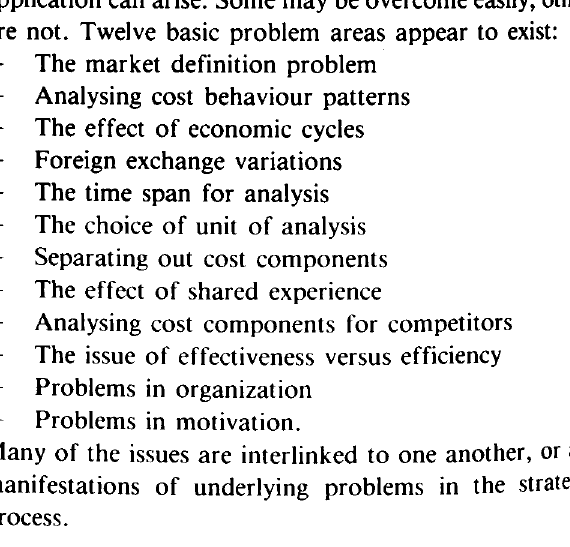
History of solid state electronic calculators up to